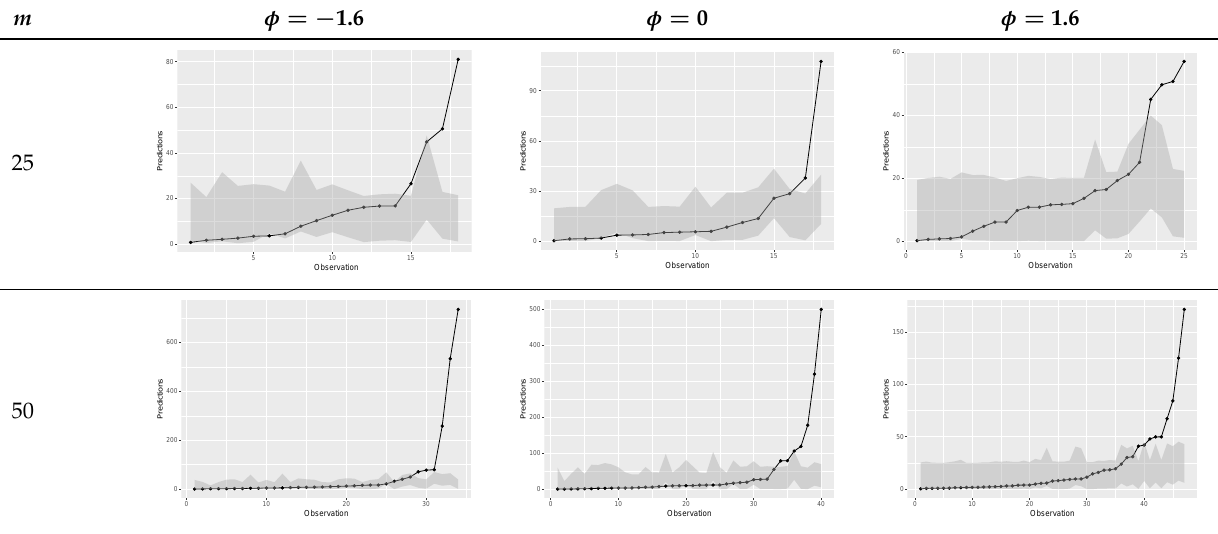
Table 2. Prediction bands of independent compound regression model for over-, equi- and under- dispersed